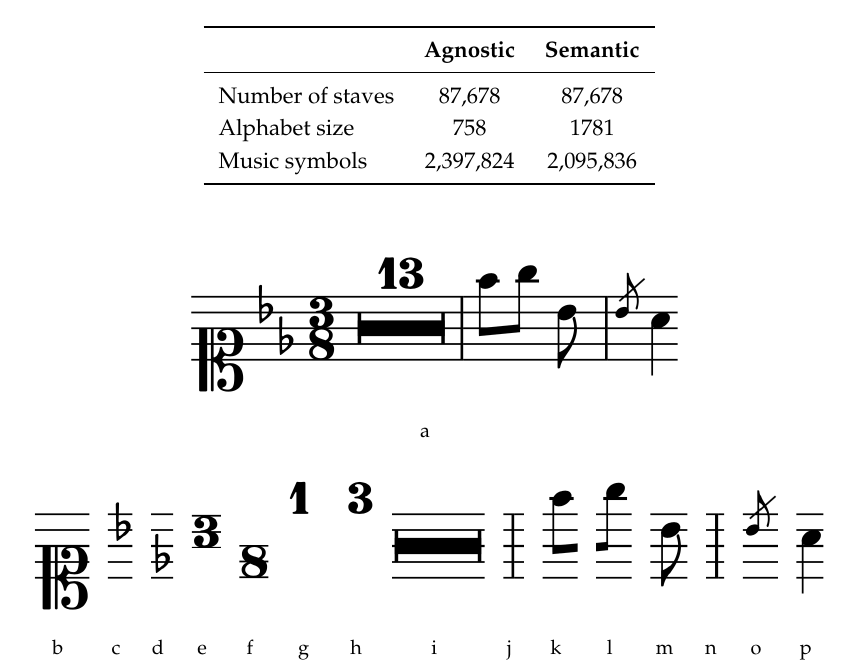
Figure 3. Graphical symbol division example. (a) Beginning of incipit RISM ID no. 000108339. Ormisda . Giuseppe Maria Orlandini; (b)–(p) Symbol division; (q) Agnostic